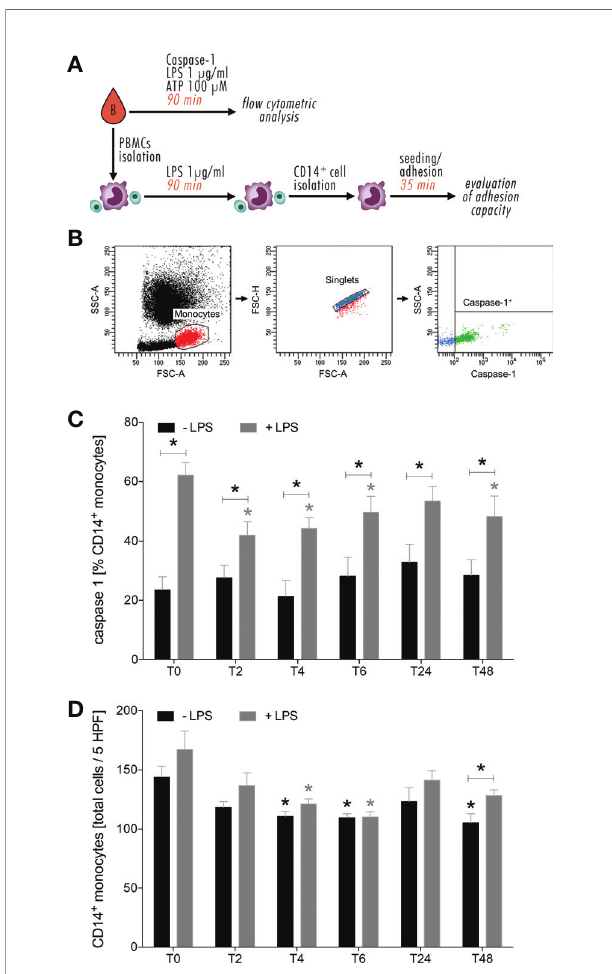
FIGURE 6 | Impact of acute alcohol intoxication on in fl ammasome activation in monocytes and their adhesive capacity upon LPS and ATP or only LPS stimulation ex vivo . Experimental design and representative gating strategy for caspase-1 is shown in (A, B) . Percentage expression of caspase-1 in CD14 + monocytes (C) and their adhesive capacity (D) following ex vivo LPS stimulation was determined in blood of healthy volunteers (n=22) before (T0) and 2 (T2), 4 (T4), 6 (T6), 24 (T24) and 48 (T48) hours after starting the alcohol consumption. Data are presented as mean ± standard error of the mean. *p < 0.05 vs . T0 and